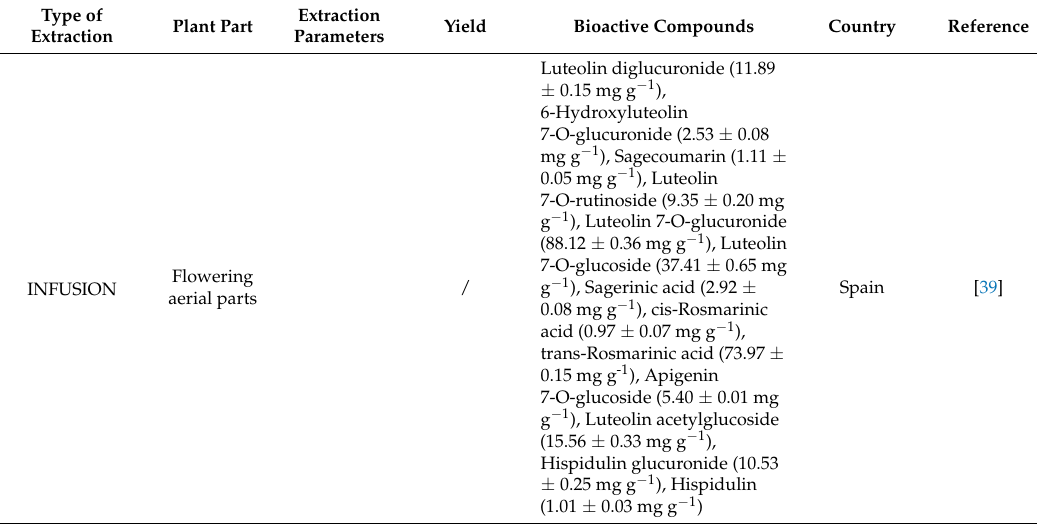
Table 3. The composition of bioactive compounds found in sage extracts, obtained by classic extraction